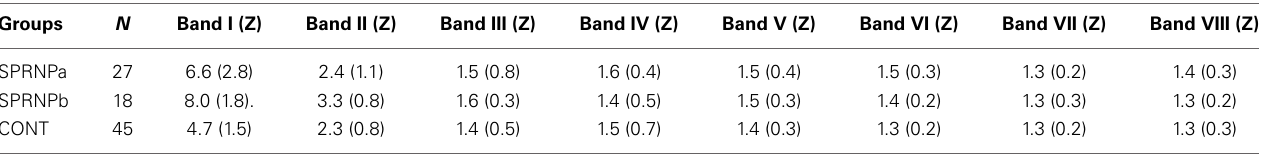
Table 4 | Coherence values of MU pairs with similar firing range.